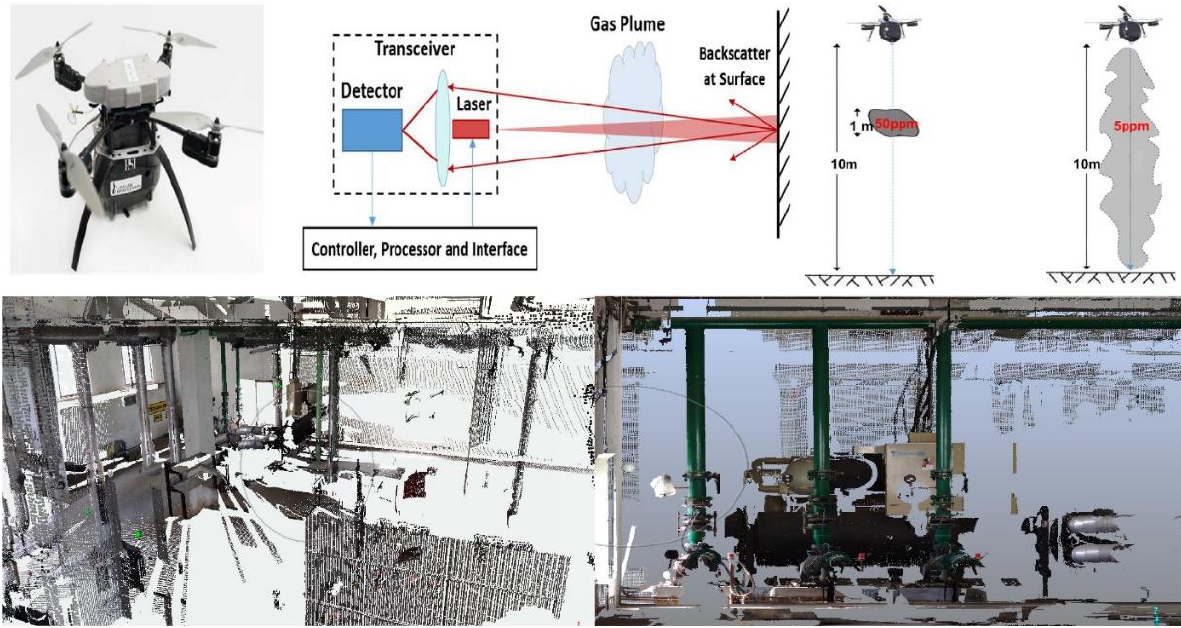
Figure 17. Functioning of UAV sensors and receivers and LIDAR data collected from RGIPT Amethi of pipe leakages. The image is in the form of LIDAR data points.